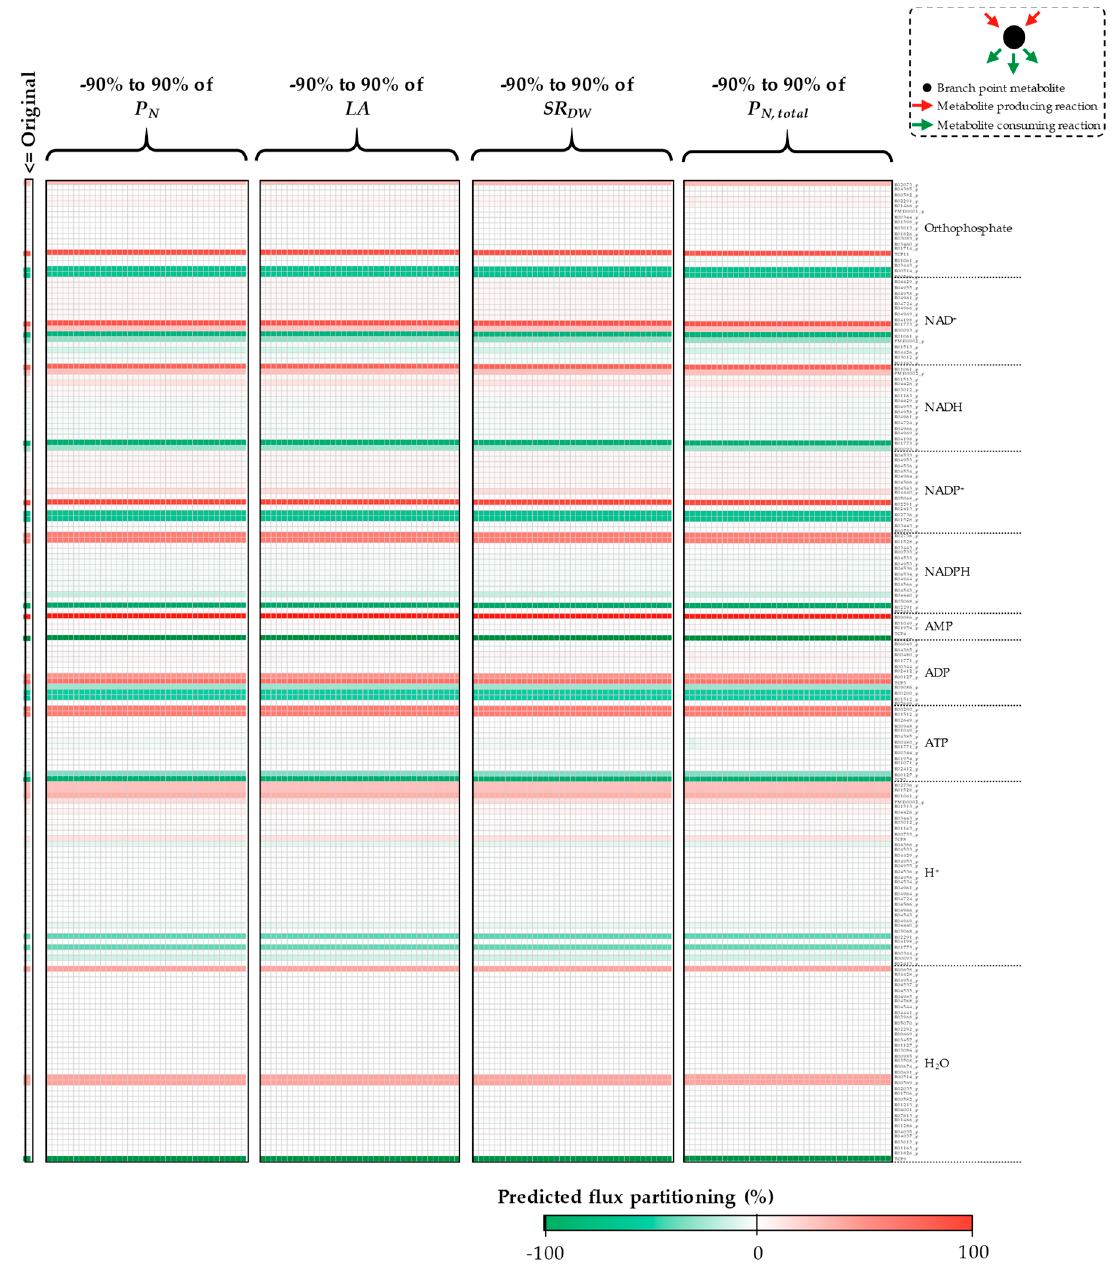
Figure A8. The sensitivity of the plastidial reaction flux partitioning to variations in the sucrose uptake rate-related data. Details of the metabolic branch points along with the corresponding reactions are provided in the Supplementary Materials (File S2). A di ff erence in grid color between the original (first column) and predicted fluxes is indicative of dissimilarity in partitioning (breakpoint). The production and consumption fluxes at each metabolic branch point were respectively denoted as positive and negative signs. LA ; total leaf area per plant; P N , photosynthetic rate; P N, total , total photosynthetic rate per plant; SR DW , storage root dry weight per plant. 2-( α -Hydroxyethyl)ThPP, 2-(alpha-hydroxyethyl)thiamine-diphosphate.